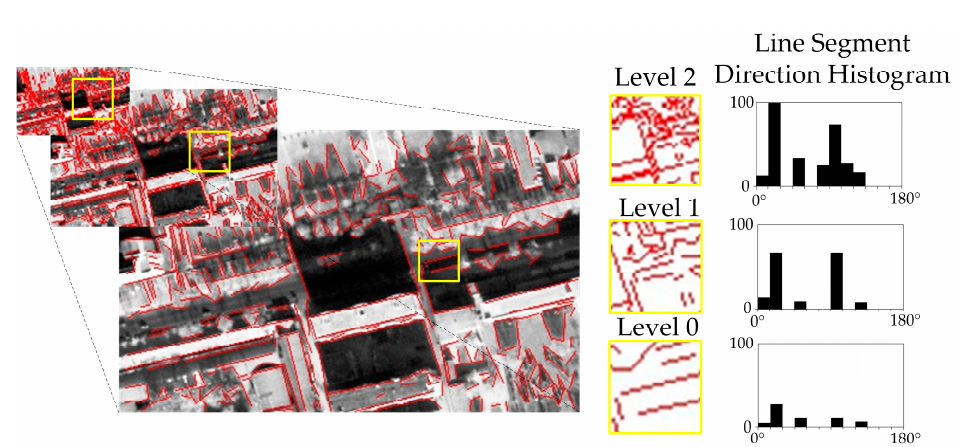
Figure 6. MLSOH (multi-scale line segment orientation histogram) descriptor.